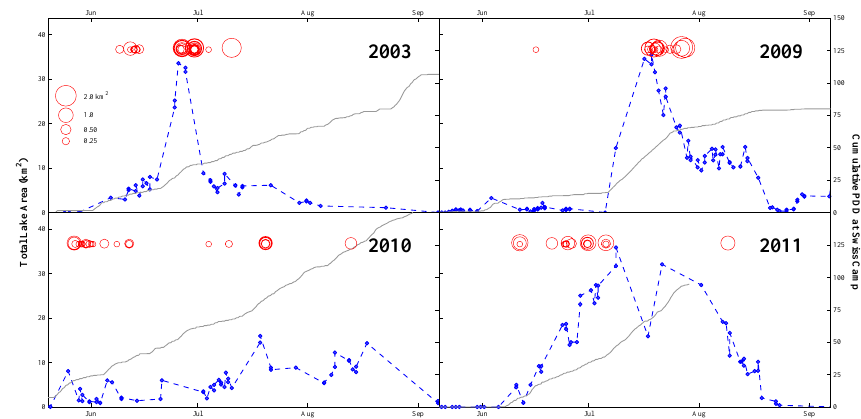
Fig. 5. Total lake coverage (blue) and rapid drainage events (red circles, see inset scale) vs. cumulative positive degree day (PDD, grey) from the GC-Net station at Swiss Camp for select years. Rapid drainage events are plotted at arbitrary vertical axis value to show temporal relationships. Lake filling begins just prior to PDD accumulation at Swiss Camp due to its higher elevation (1176m) than the lowest lakes (369m). Note the narrow coverage peaks and concentrated rapid drainage timing in low cumulative PDD years (2003, 2009). High PDD years may exhibit similar peak coverage and temporally localized drainage events (2011) or highly variable coverage and sporadic drainages (2010). Data from 29 July 2011 to 30 September 2011 are unavailable.